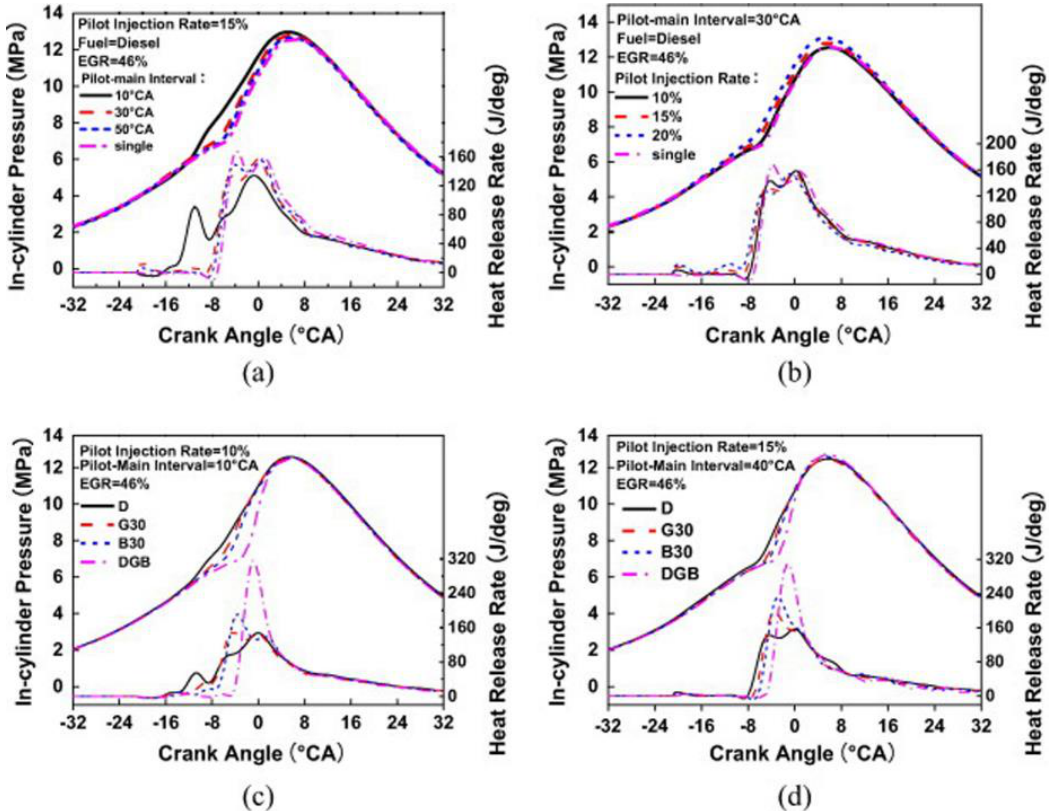
Figure 8. E ff ects of pilot injection strategies and fuel properties on in-cylinder pressure and heat release rate [84]. ( a ) pilot injection rate = 15%, di ff erent pilot-main interval, in-cylinder pressure and HRR curve with CA; ( b )constant pilot-main interval, di ff erent pilot injection rate, in-cylinder and HRR curve with CA; ( c ) and ( d ) compares the in-cylinder pressure and heat release rate of four di ff erent fuels. Table 4. Variation of performance and emissions after advancing the first injection timing (two-stage).